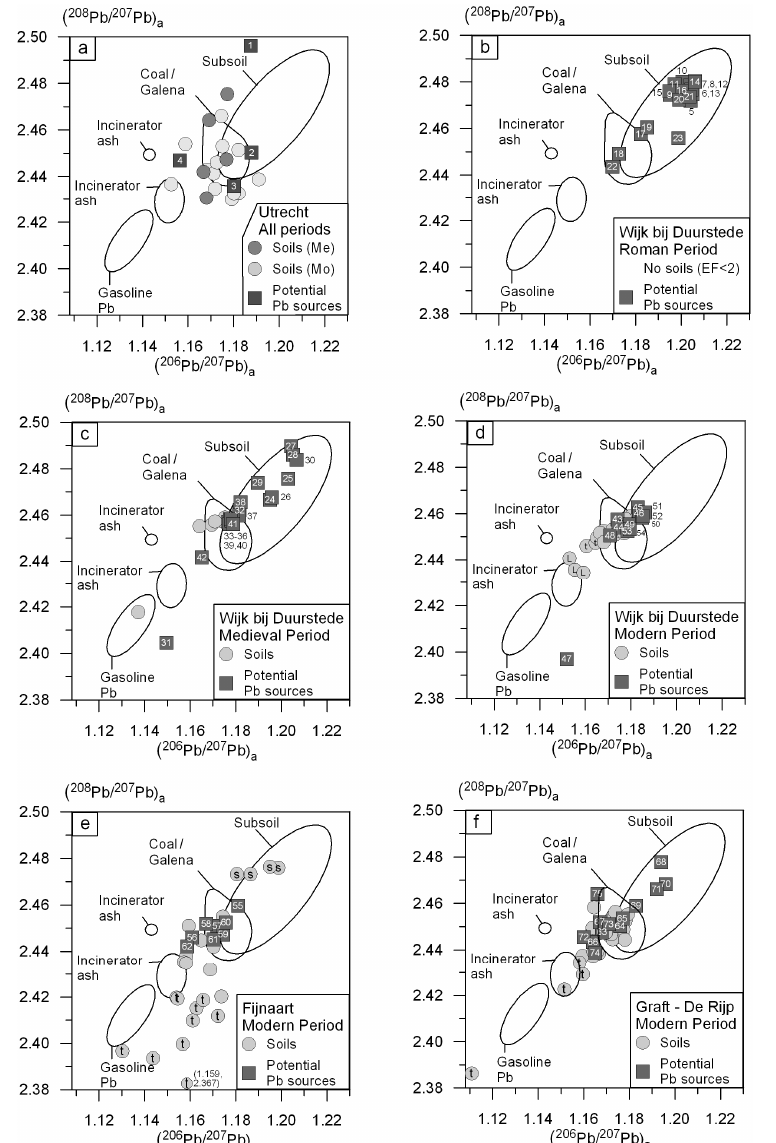
Figure 4. ( 208 Pb/ 207 Pb) a versus ( 206 Pb/ 207 Pb) a in urban soils and potential anthropogenic Pb sources